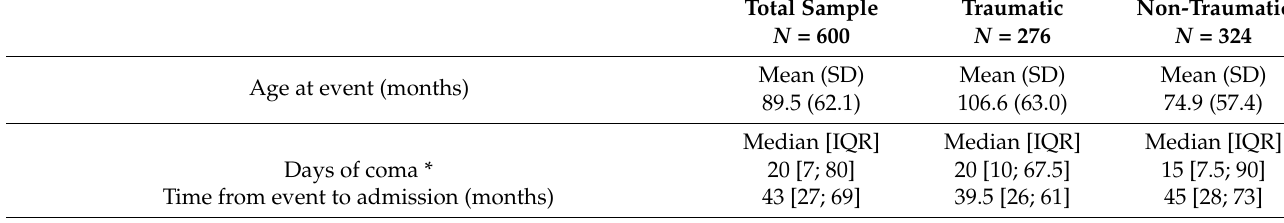
Patients in unresponsive wakefulness syndrome for at least one year